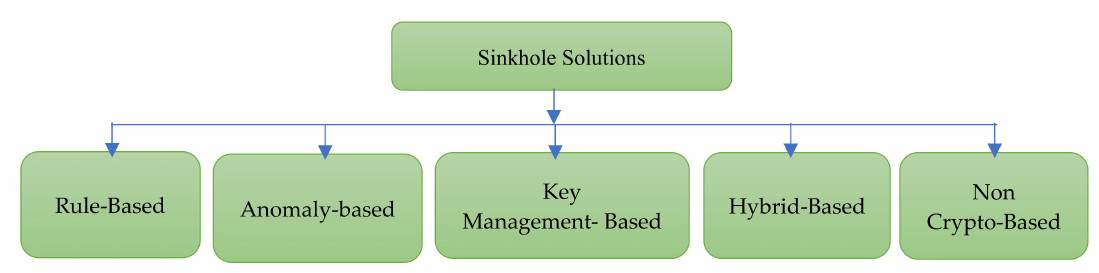
Figure 2. Sinkhole attack solutions classifications